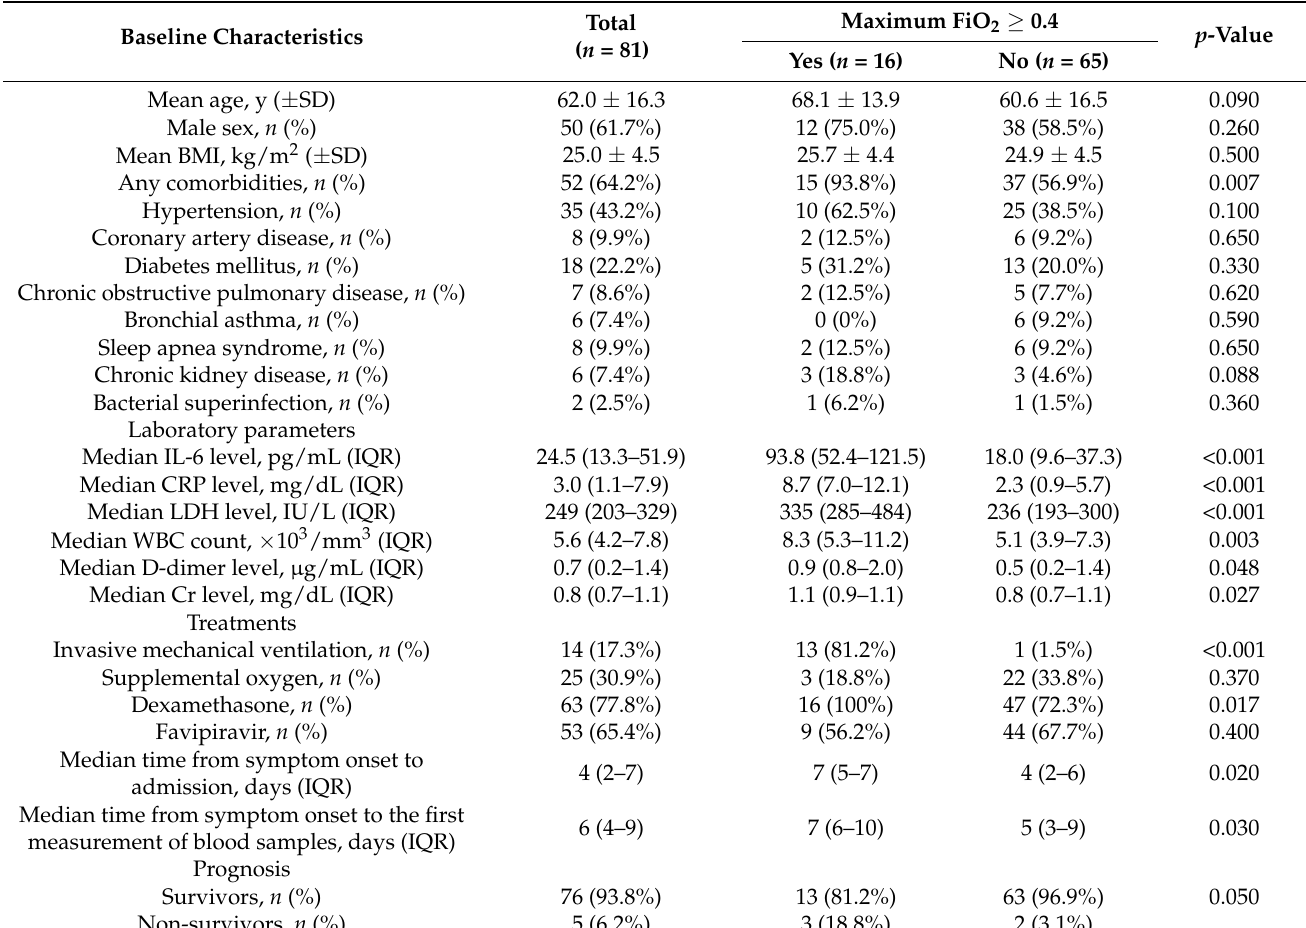
Table 1. Clinical characteristics between the two